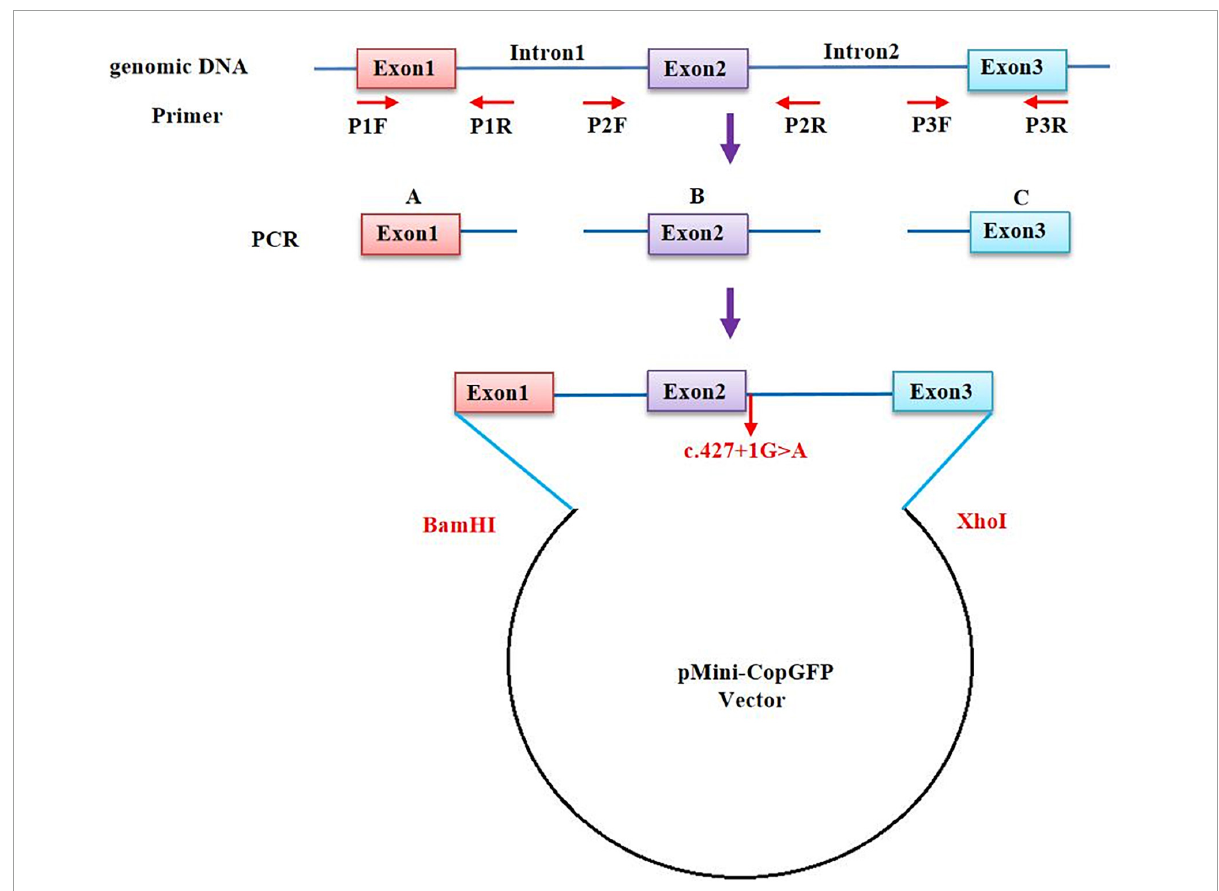
FIGURE2 A schematic diagram of primer design for a minigene assay of the BCL11B gene. The upstream and the downstream of Intron 1 and Intron 2 were retained, respectively, and the intermediate sequences were removed (NG_027894.1: from g.5780 to g.18155 of Intron 1; from g.20001 to g.44443 of Intron